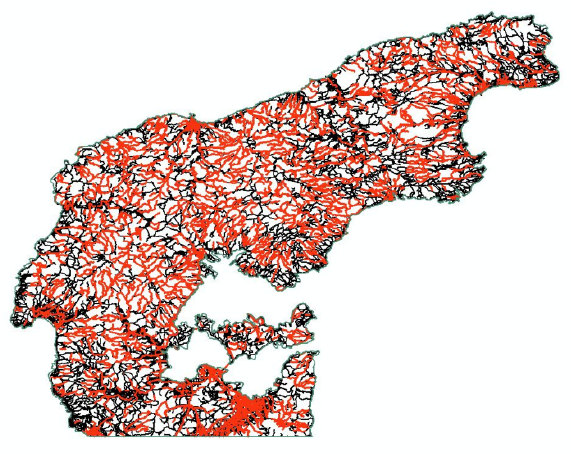
Figure 2. Spatial correlation analysis of linear objects